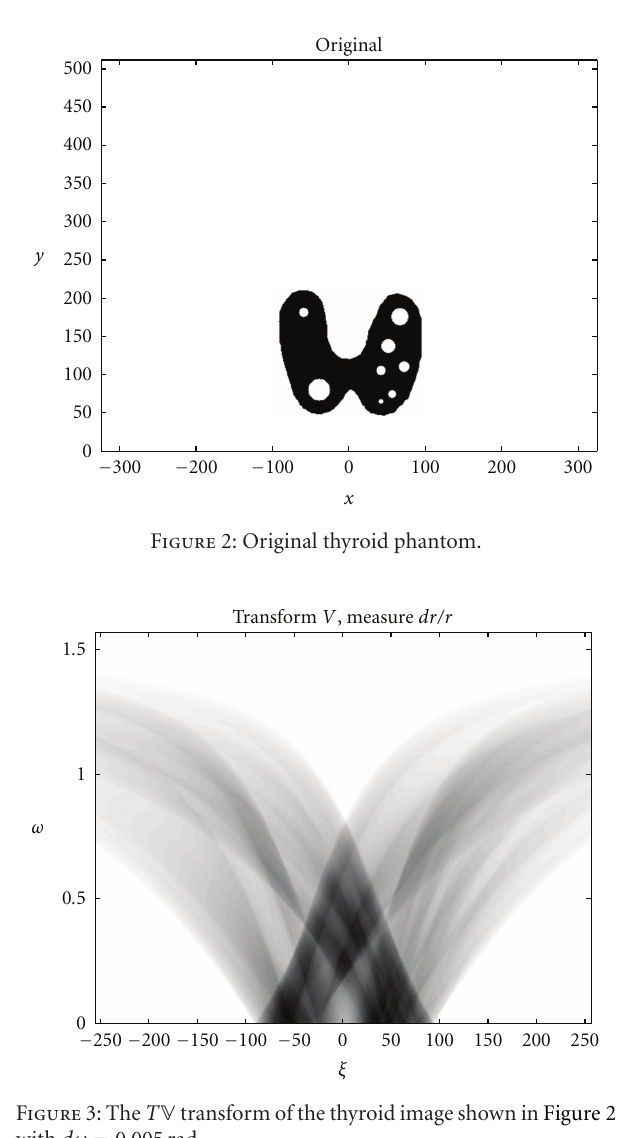
Figure 3: The T V transform of the thyroid image shown in Figure 2 with dω = 0 . 005 rad.